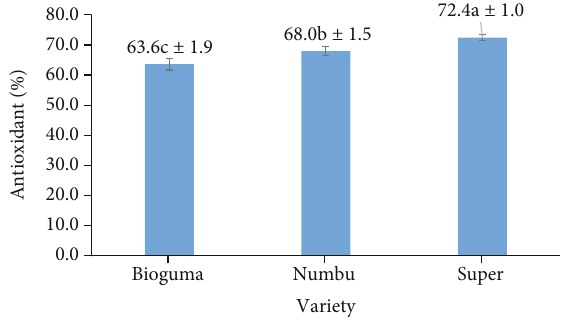
Figure 2: Tannin content of three varieties of polished sorghum grains.